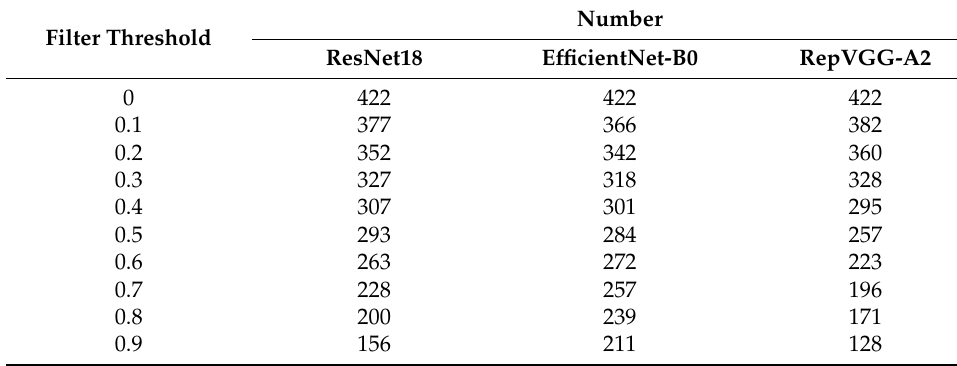
Table 5. Image numbers for spherular pearlite gradation with each filter threshold.